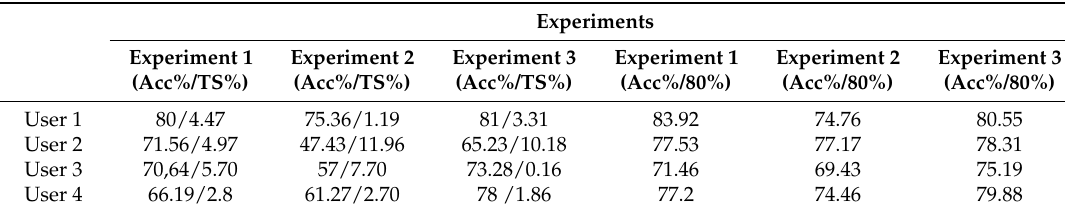
Table 2. Classification performance obtained for IMU sensors.